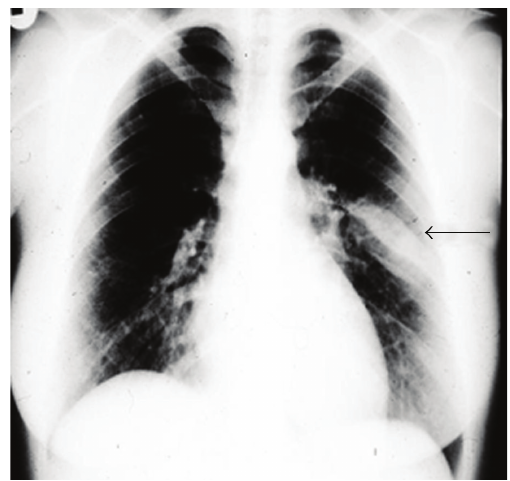
Figure 1: Chest X-ray shows a lesion in the 7th left rib.